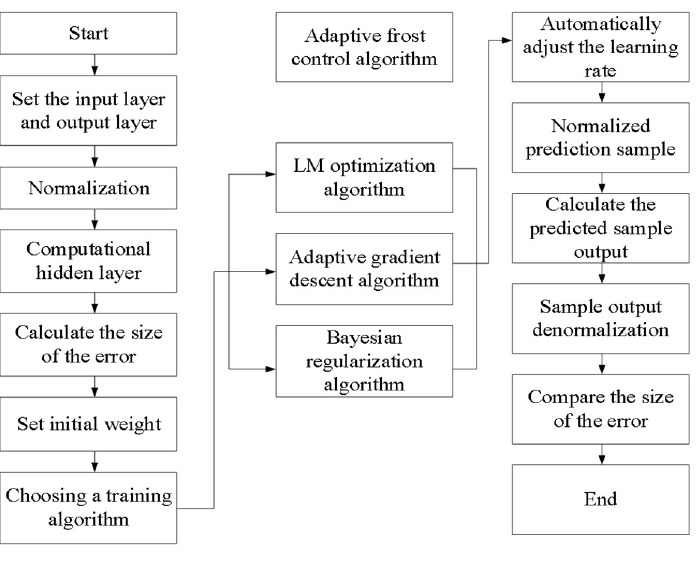
Fig 2. Flow chart of adaptive network control algorithm to predict the amount of